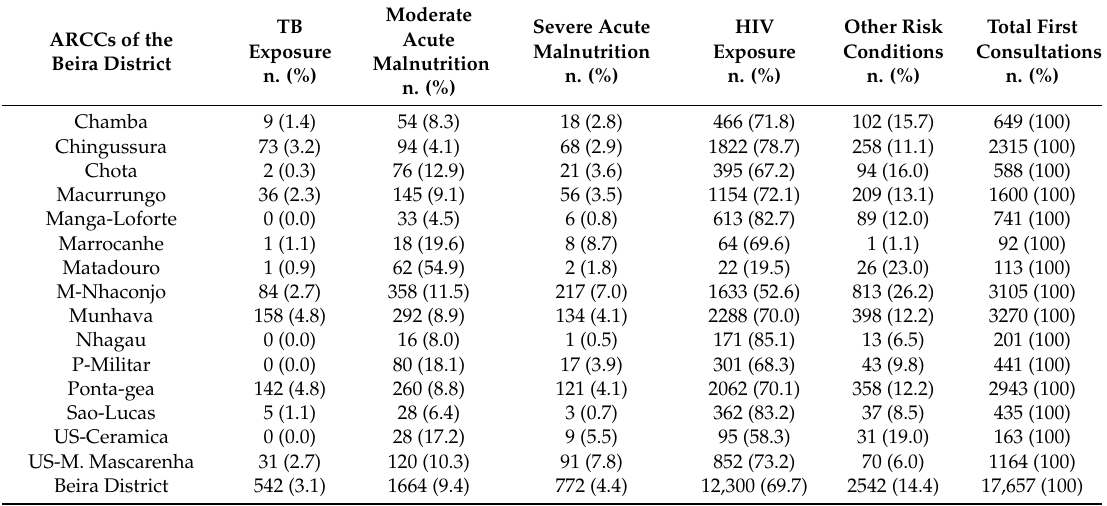
Table 1. First consultations, by motivation and overall, at ARCCs of the Beira District, 2015–2017.